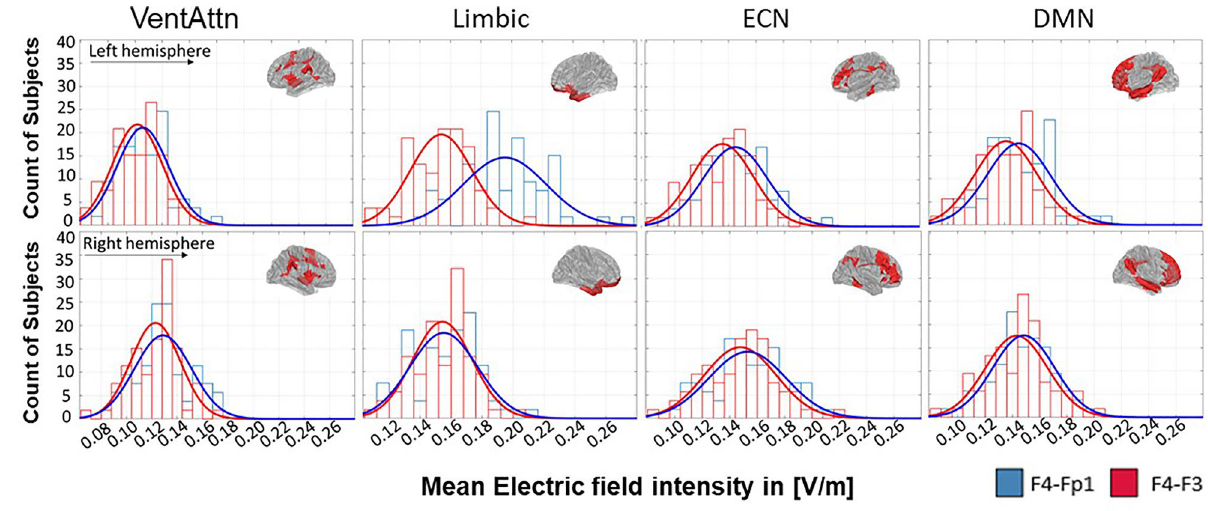
Figure 5. Distribution of the EF in the large-scale brain networks that receive EFs above the threshold. Distribution of the EF intensity in volt per meter ([V/m]) are represented for F4–Fp1 (blue line) and F4–F3 (red line) electrode montages in the left (first row) and right (second row) hemisphere. VentAtn ventral attention network, Limbic limbic system network, ECN executive control network, DMN default mode